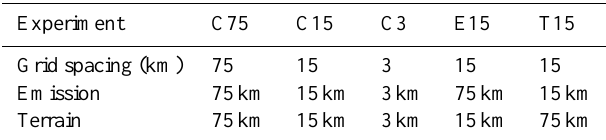
Table 2. Simulation